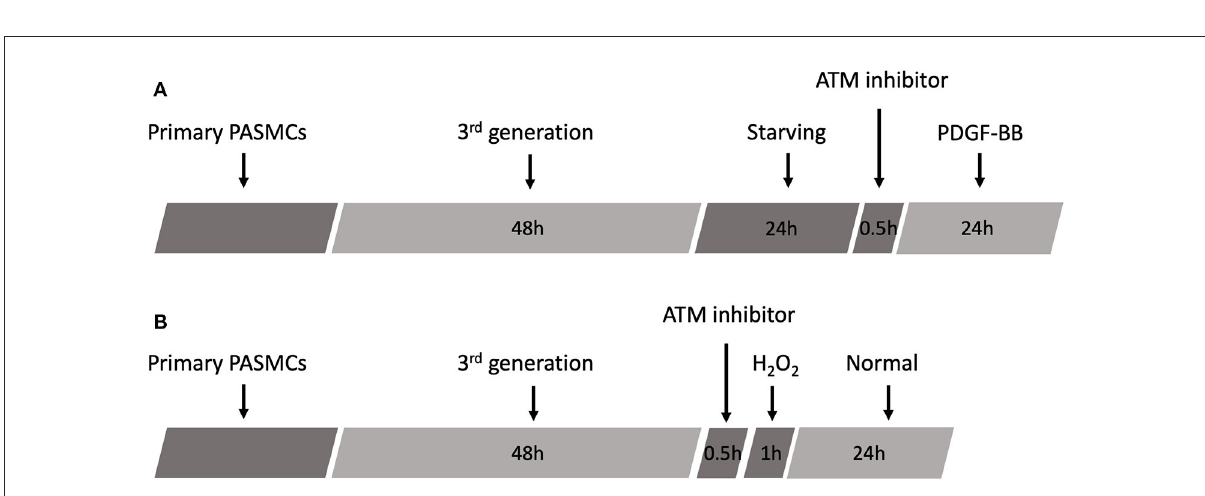
FIGURE2 Schematic of experimental design. (A) Schematic protocol of PDGF-BB treatment. (B) Schematic protocol of H 2 O 2 treatment.